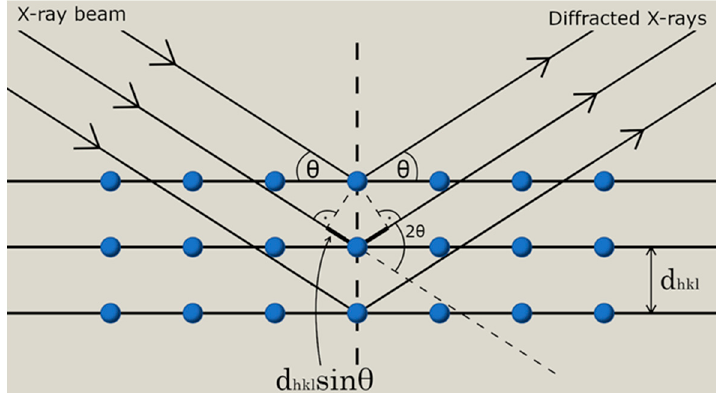
Figure 1. X-ray diffraction in a set of parallel planes ( hkl ) in crystal. Figure 1. X-ray di ff raction in a set of parallel planes ( hkl ) in